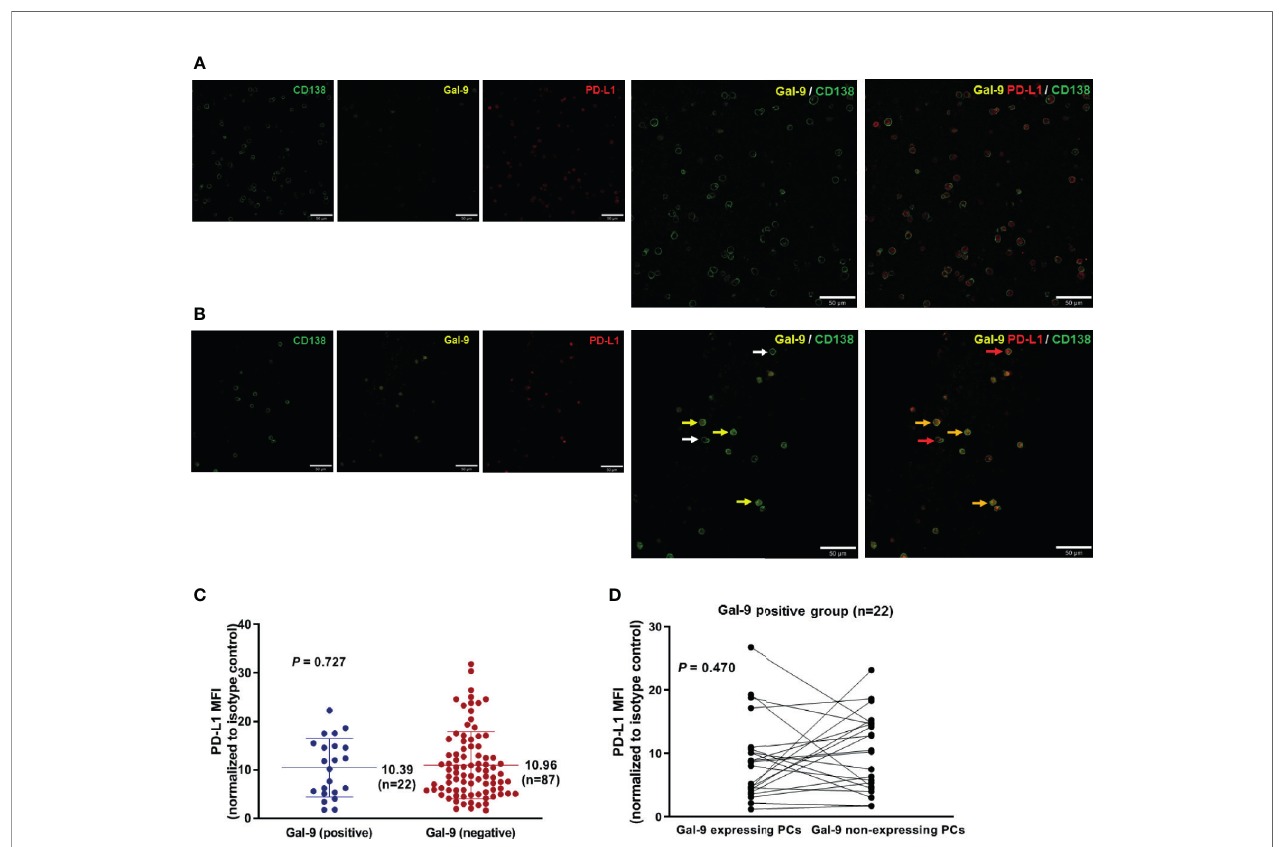
FIGURE 2 | Relationship between Gal-9 and PD-L1 expression. (A) Representative Gal-9-negative images are shown. (B) Representative Gal-9-positive images are shown. Yellow and white arrows indicate CD138-positive plasma cells with and without Gal-9 expression, respectively. Red arrows indicate PD-L1-expressing